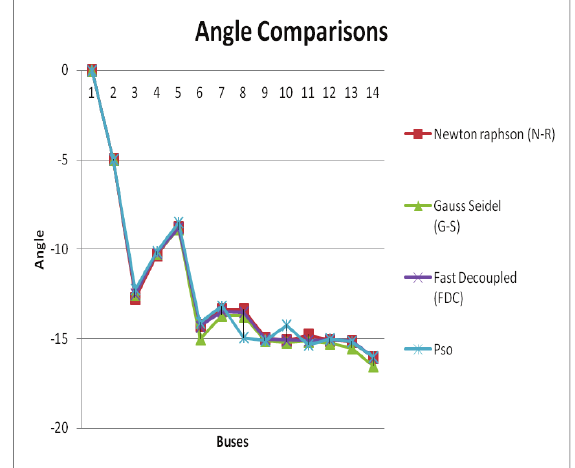
Fig.10. Phase magnitude comparison